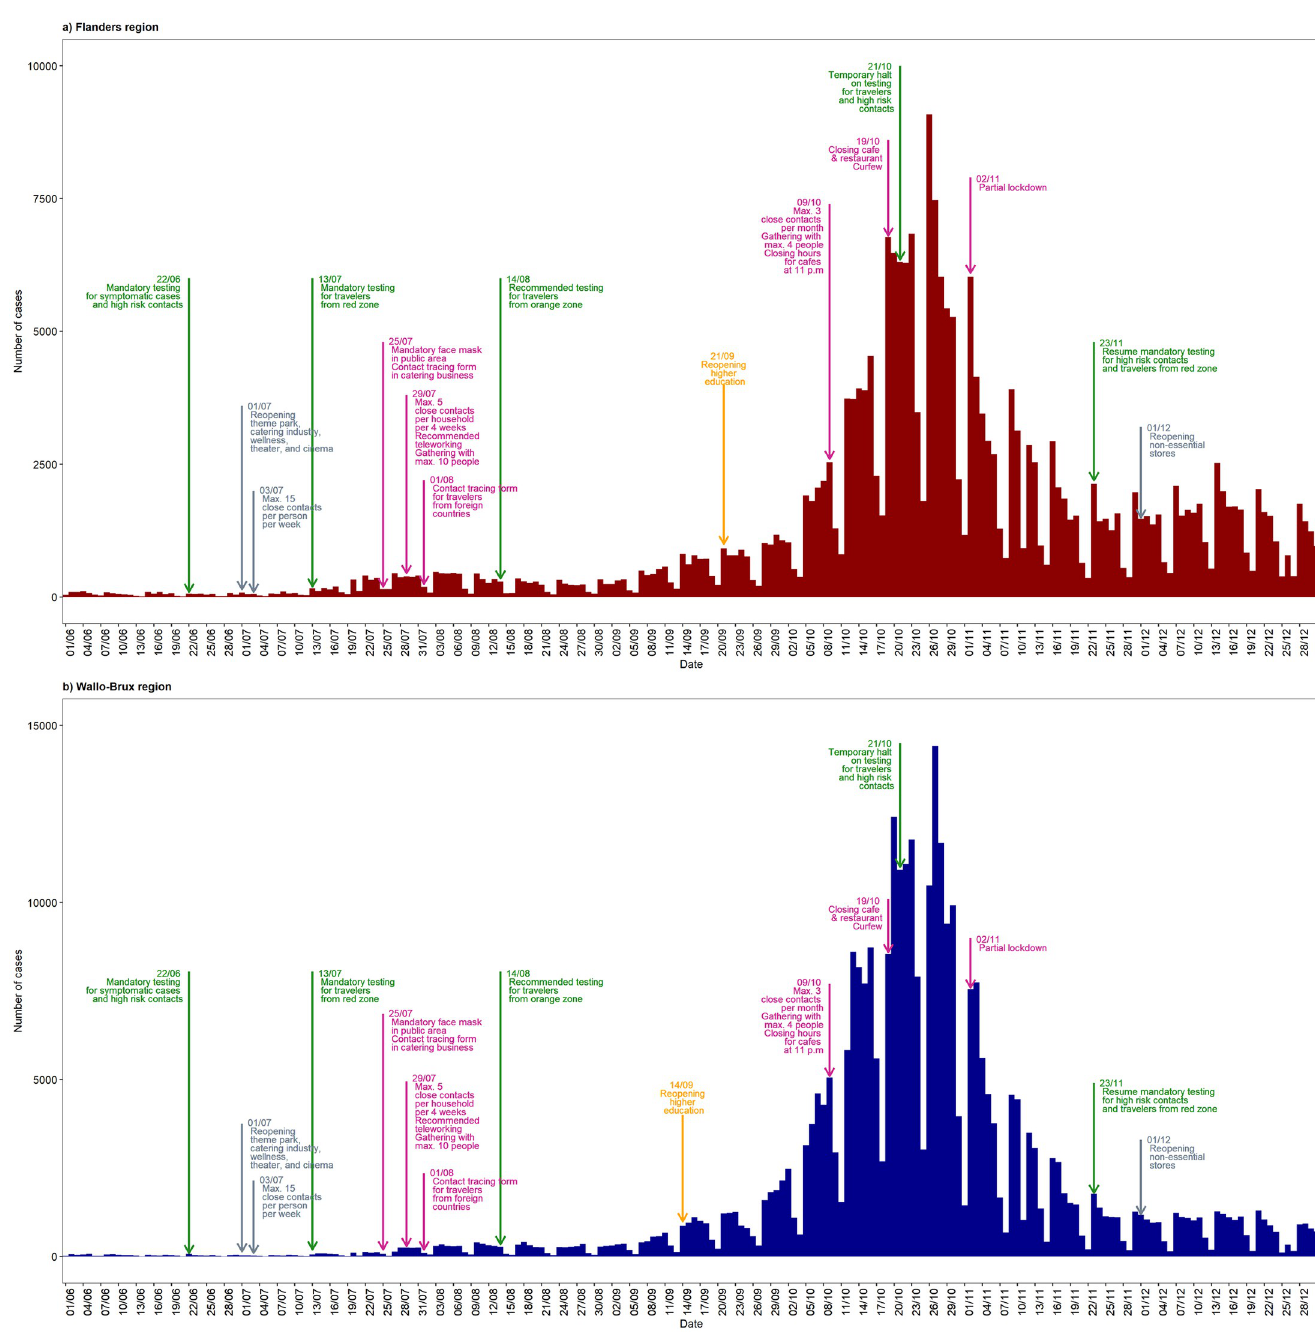
Fig 5. COVID-19 epidemic curve. Different colors indicate different type of strategies taken in this period. Green = testing strategy, grey = relaxation strategy, purple = preventive